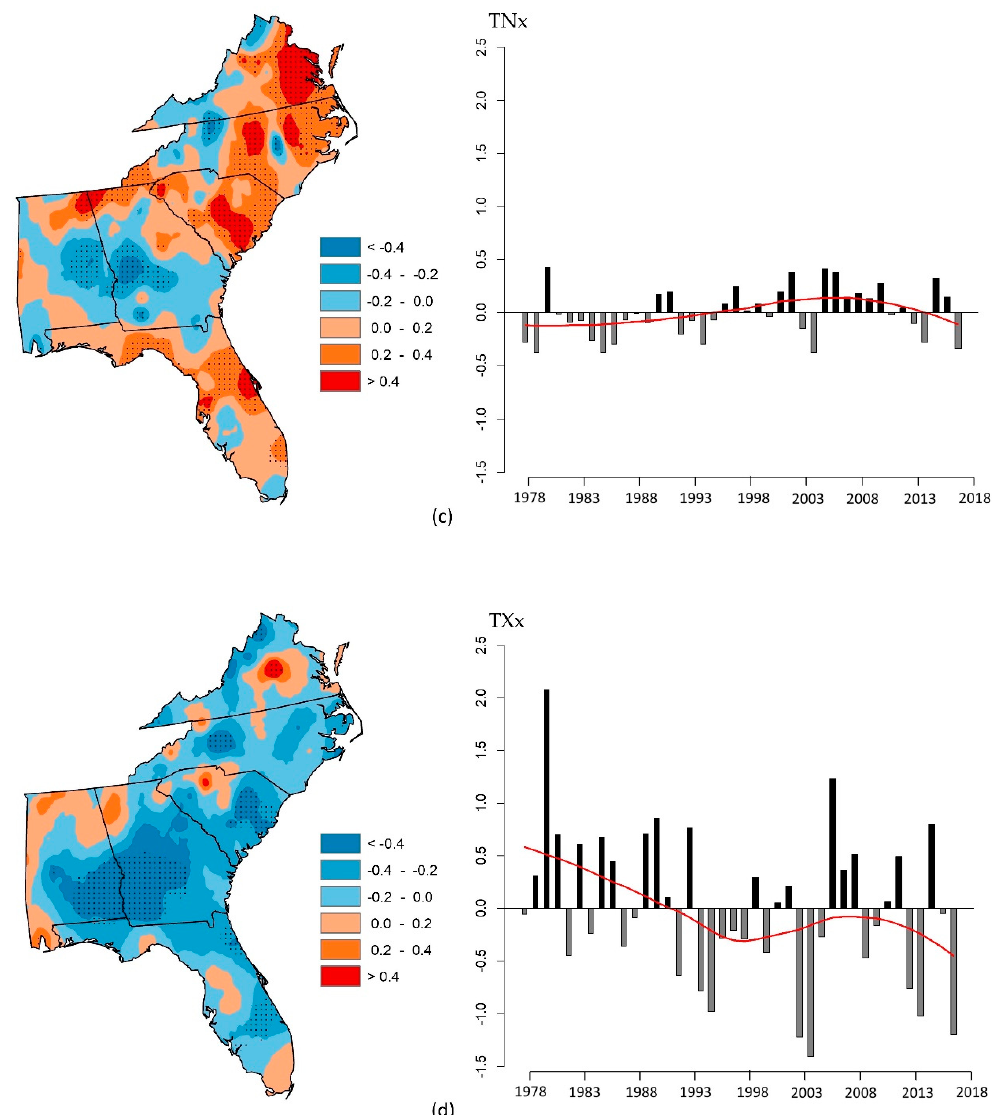
Figure 6. Same as Figure 5, but for absolute indices: ( a ) coldest night (TNn); ( b ) coldest day (TXn); ( c ) warmest night (TNx); ( d ) hottest day (TXx). Map units: °C per decade; plot units: °C.